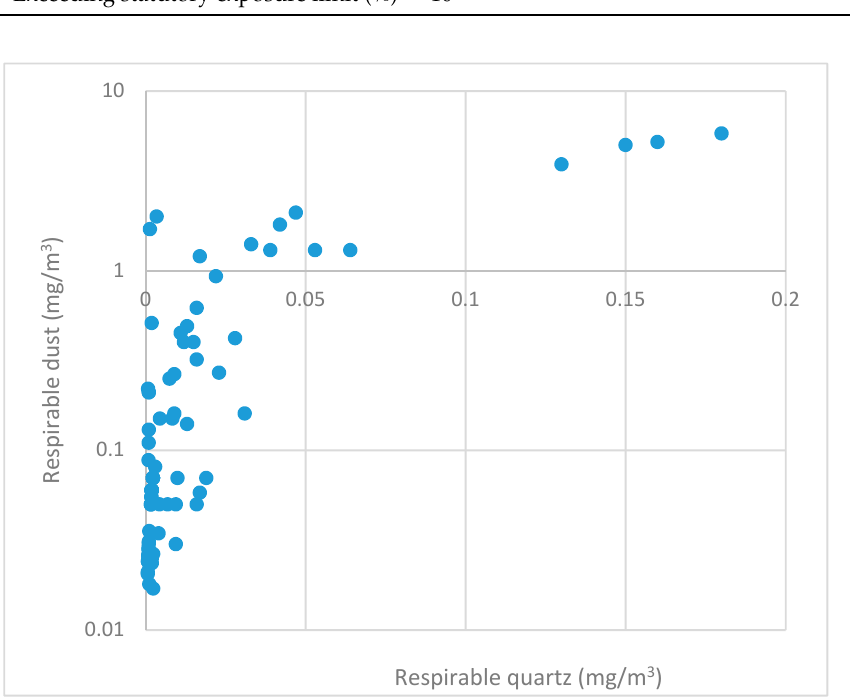
Figure 7. General air respirable quartz and dust concentrations at the investigated building sites. Reproduced with permission from Tuomi et al., Finnish Institute of Occupational Health, 2022 [34]. Table 3. Respirable quar tz and dust contents of general air on construction sites.